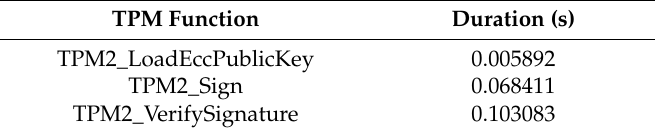
Table 4. Measurements of the executed TPM functions related to the ECDSA based proposed concept.